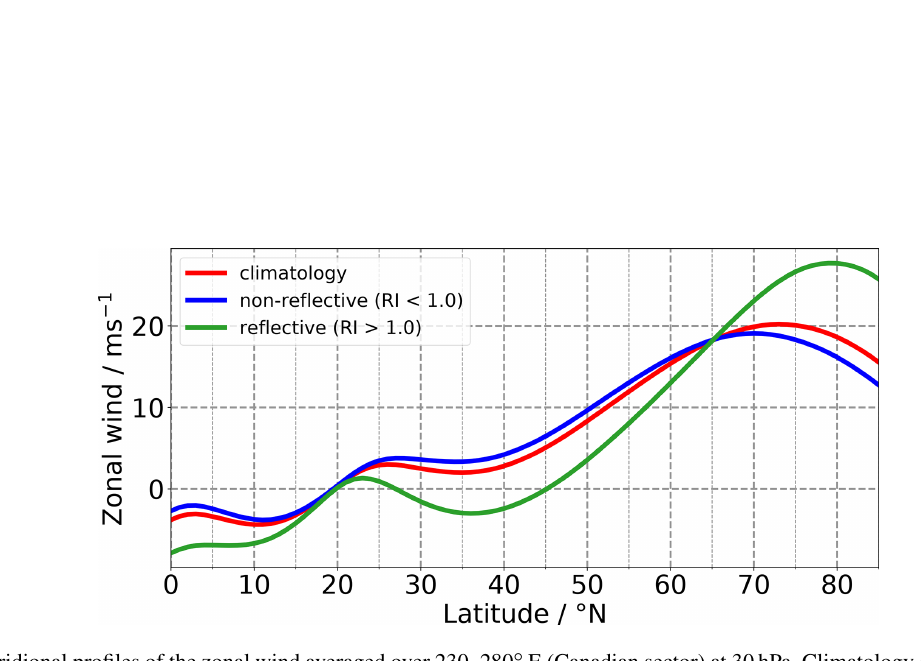
Figure A2. Meridional profiles of the zonal wind averaged over 230–280 ◦ E (Canadian sector) at 30hPa. Climatology of all winter days (red line), days when RI > 1 (green line) and days when RI < 1 (blue